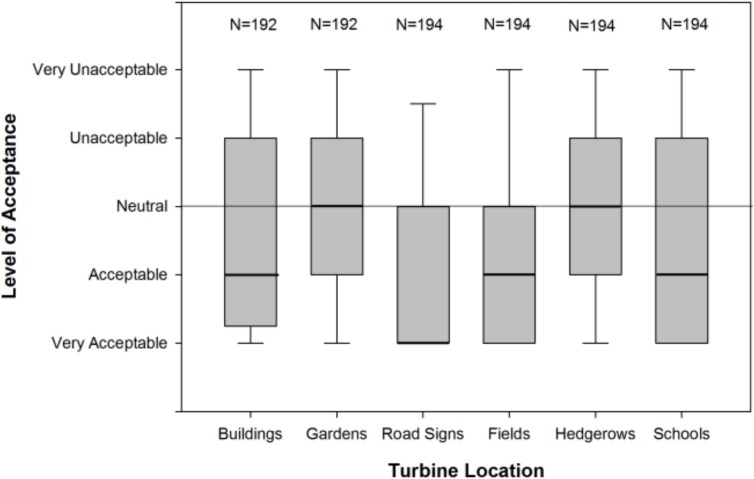
The acceptability of SWTs in different settings.The thick line shows the median while the outer edge of boxes shows 25th & 75th percentile. Confidence intervals represent 10th & 90th percentiles.